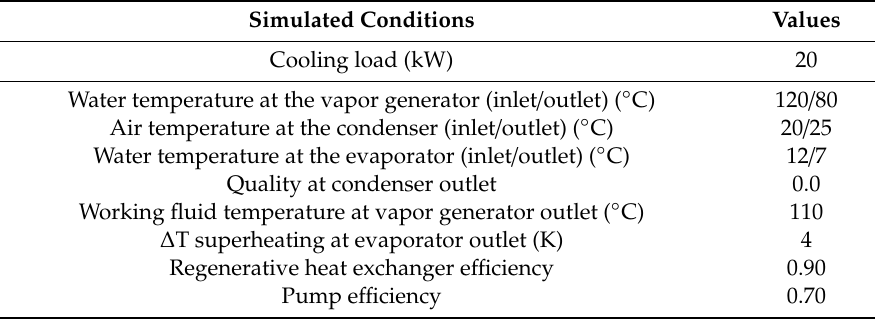
Table 2. Specification of the simulated boundary conditions.